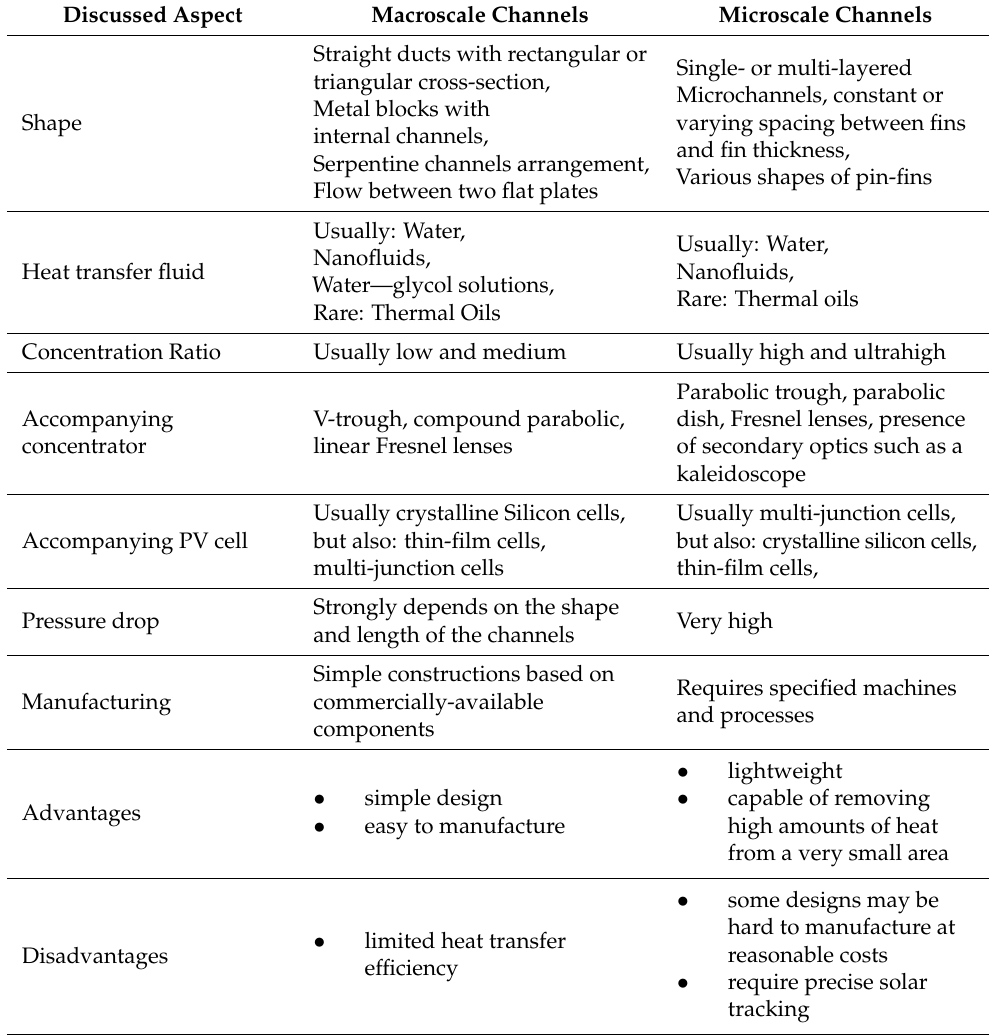
Table 6. Comparison of heat extraction devices with micro- and macro-scale channels.